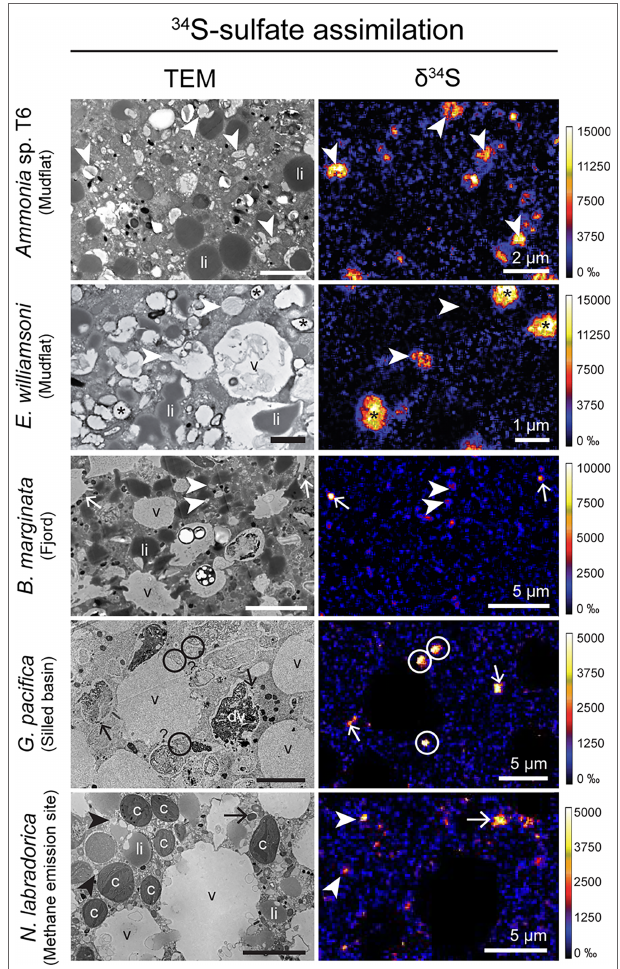
FIGURE 4 | TEM micrographs of different benthic foraminiferal species’ cytoplasm and corresponding NanoSIMS images of 34 S-assimilation (expressed as δ 34 S in ‰). Arrows: electron-opaque bodies, arrowheads: fibrillar vesicles, asterisk: vesicles with thick membranes, circles: unidentified 34 S-labeled structures, c, kleptoplasts; li, lipid droplets; v,